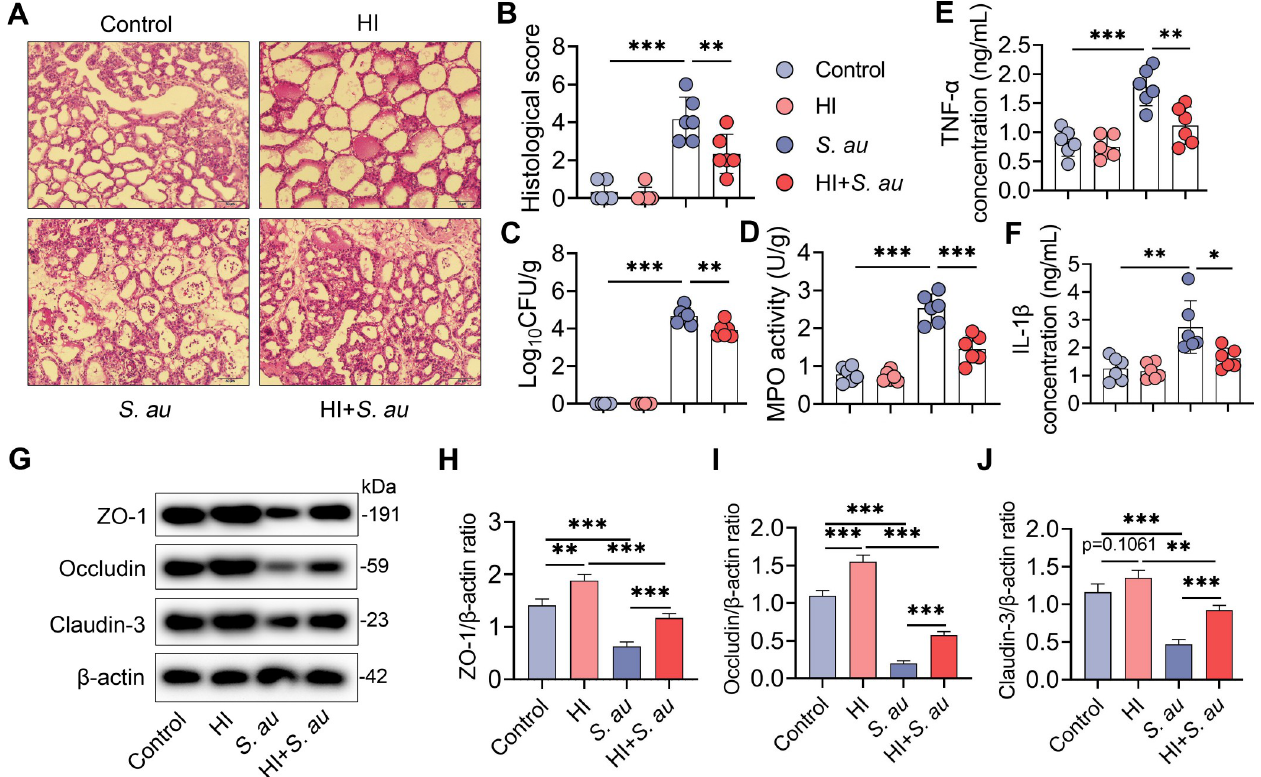
Fig 2. A high-inulin diet attenuates S . au -induced mastitis in mice. Mice that were pregnant for a week were randomly divided into four groups, and fed an AIN93G diet (control) or high-inulin diet (AIN93G + 20% inulin, HI) for three weeks followed by the S . au -induced mastitis model ( S . au and HI + S . au groups) (n = 6 per group). A . Representative H&E-stained images of the mammary glands from different treatment groups (scale bar, 50 μ m). B . Histological score of the mammary gland based on H&E-stained sections (n = 6). C . Mammary bacterial burden from the indicated mice (n = 6). D-F . Inflammatory markers, including MPO activity ( D ), TNF- α ( E ) and IL- β ( F ), from the indicated groups (n = 6). G . Representative images of mammary tight junction (TJ) proteins, including ZO-1, Occludin and Claudin-3, by western blotting. H-I . Relative intensity of TJ proteins including ZO-1 ( H ), Occludin ( I ) and Claudin-3 ( J ) using β -actin as an endogenous control. Data are presented as the means ± SD ( B-F , H-J ) and one-way analysis of variance (ANOVA) was performed for statistical analysis ( B-F , H-J ). � p < 0.05, �� p < 0.01 and ��� p < 0.001 indicate significant differences.